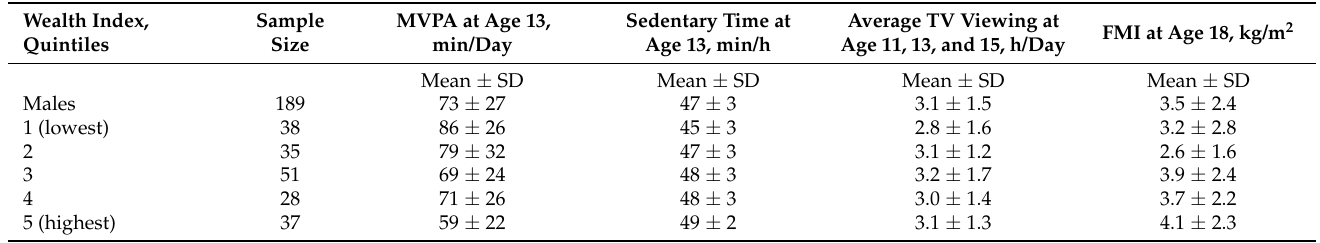
Table 1. Means of MVPA, sedentary time, TV viewing, and FMI according to wealth index quintiles among males.